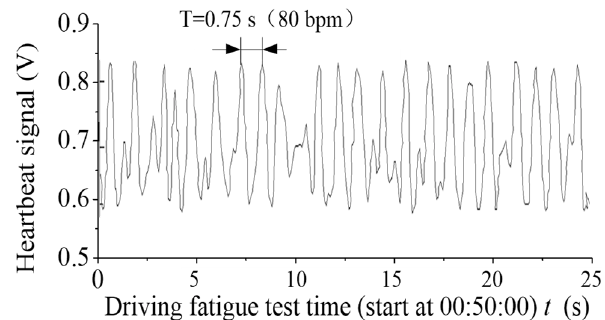
Figure 10. Time domain signal of number 181 in the vibration sensor array.